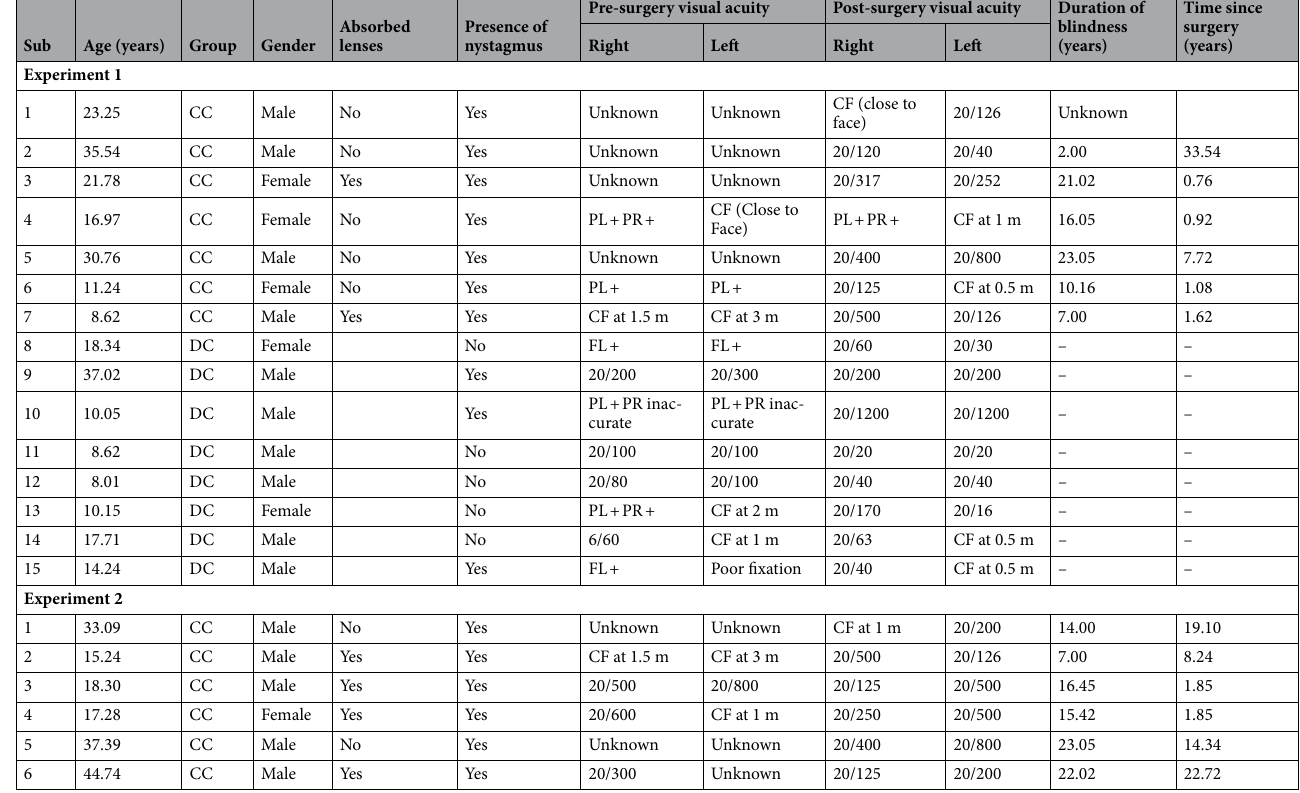
Table 1. Participant characteristics for all sight recovery participants in Experiments 1 and 2. Age was calculated on the day of testing, and duration of blindness was calculated by subtracting date of birth from date of first surgery. Time since surgery was calculated by subtracting date of first surgery from date of testing. Visual acuity is reported separately for each eye ( CF counting fingers, PL perception of light, PR projection of rays in all quadrants, FL fixate and follow